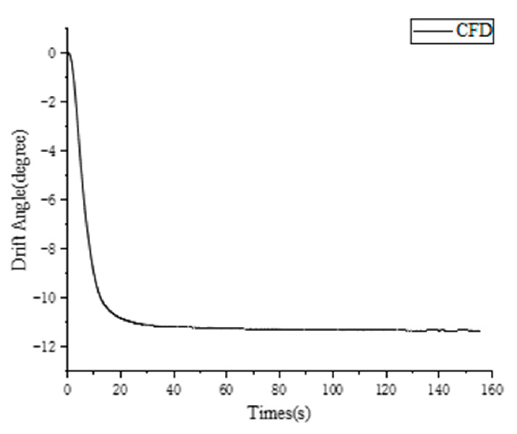
Figure 19. − 35 ◦ drift angle in CFD simulation.